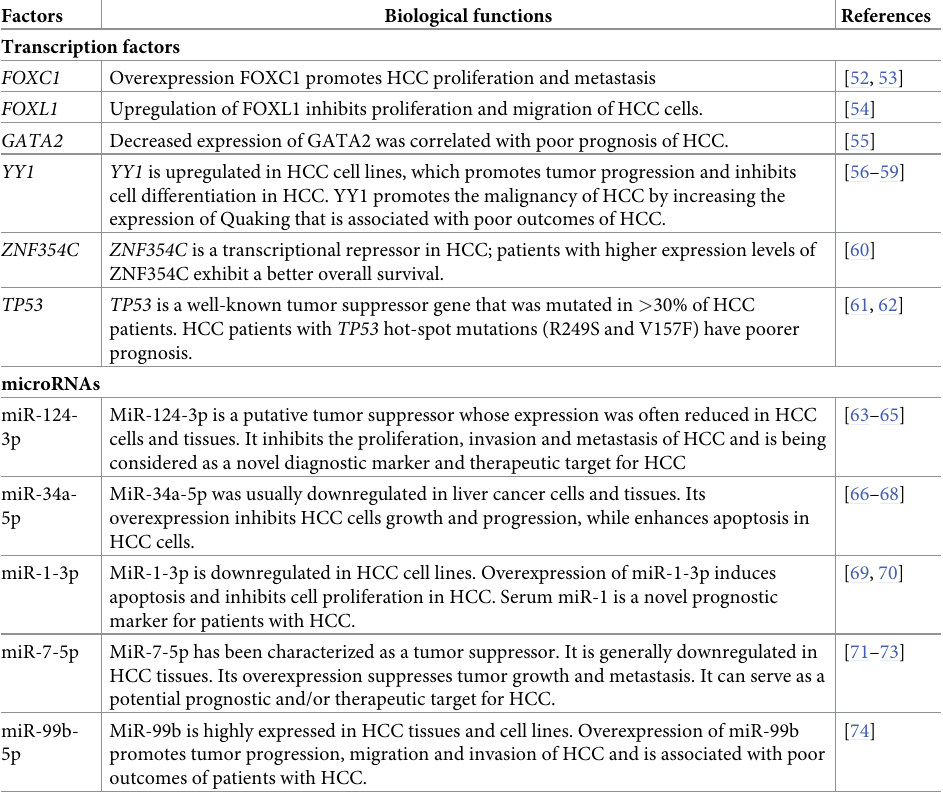
Table 2. Top regulatory signatures of common DEGs predicted from DEG-TF and DEG-miRNA interaction networks. Factors Biological